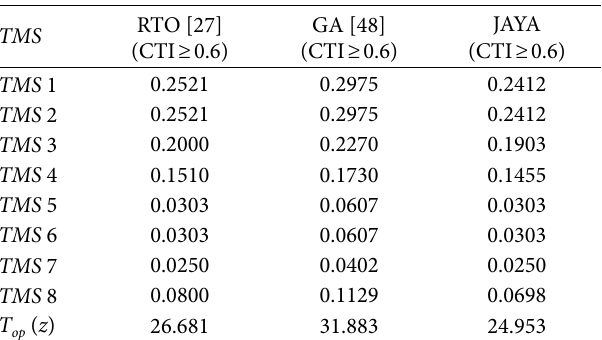
Table 9: Optimal TMS values for Case 2.